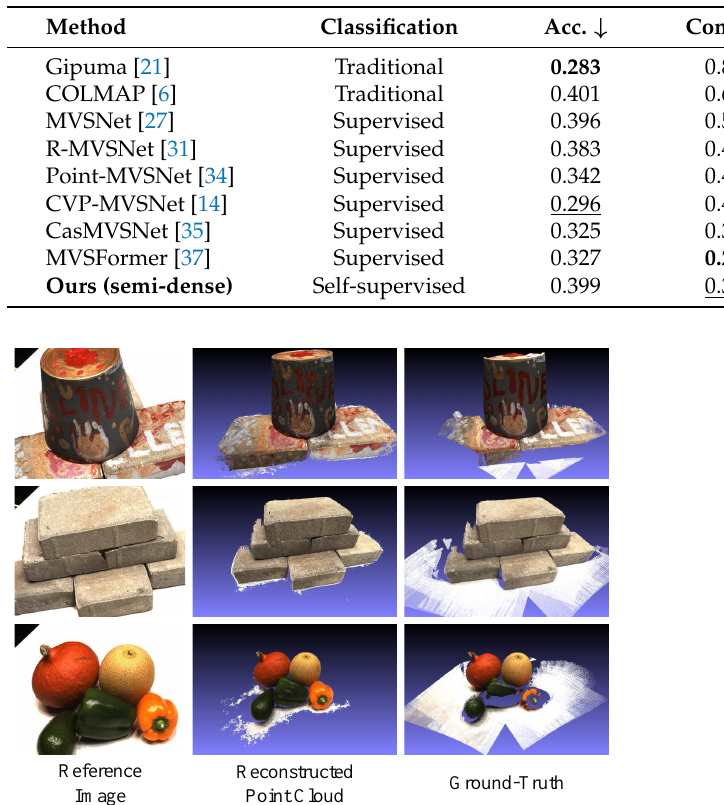
Table 2. Quantitative results of our approach against traditional and supervised MVS methods on the DTU dataset (lower is better). The best results are in bold, while the second ones are underlined.